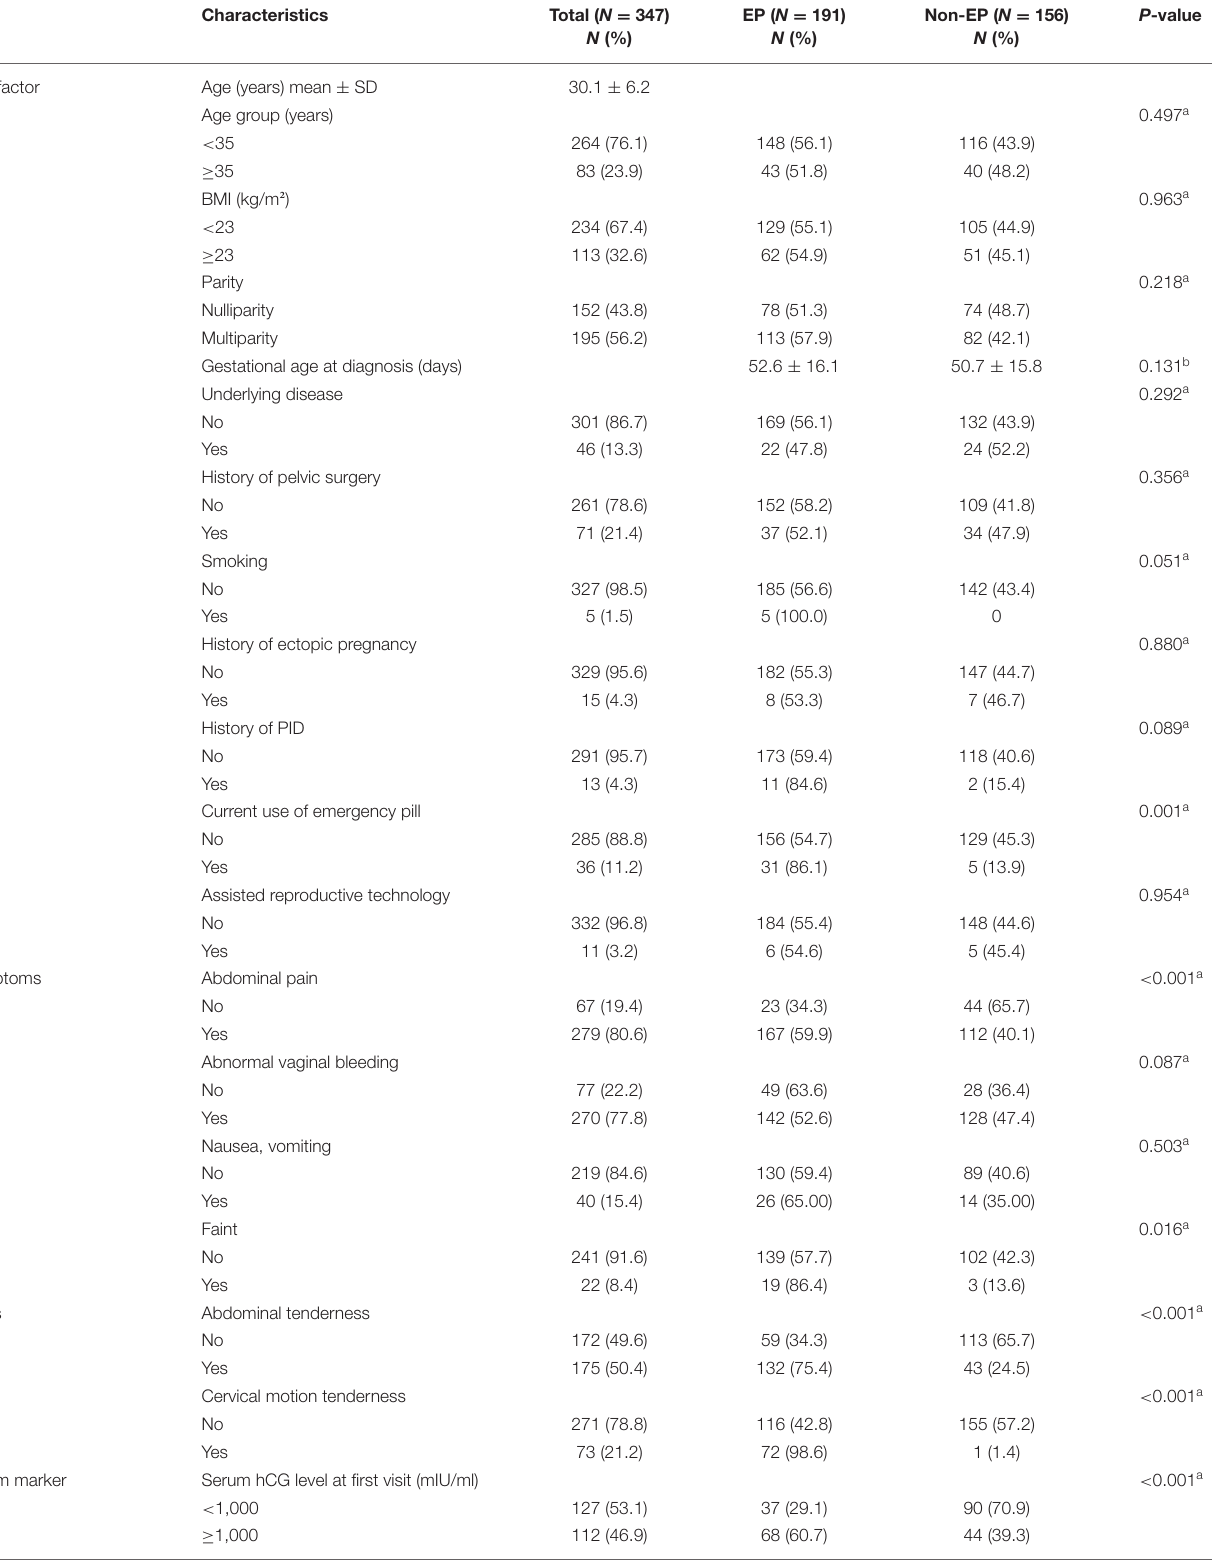
TABLE 1 | Demographic characteristics of the study